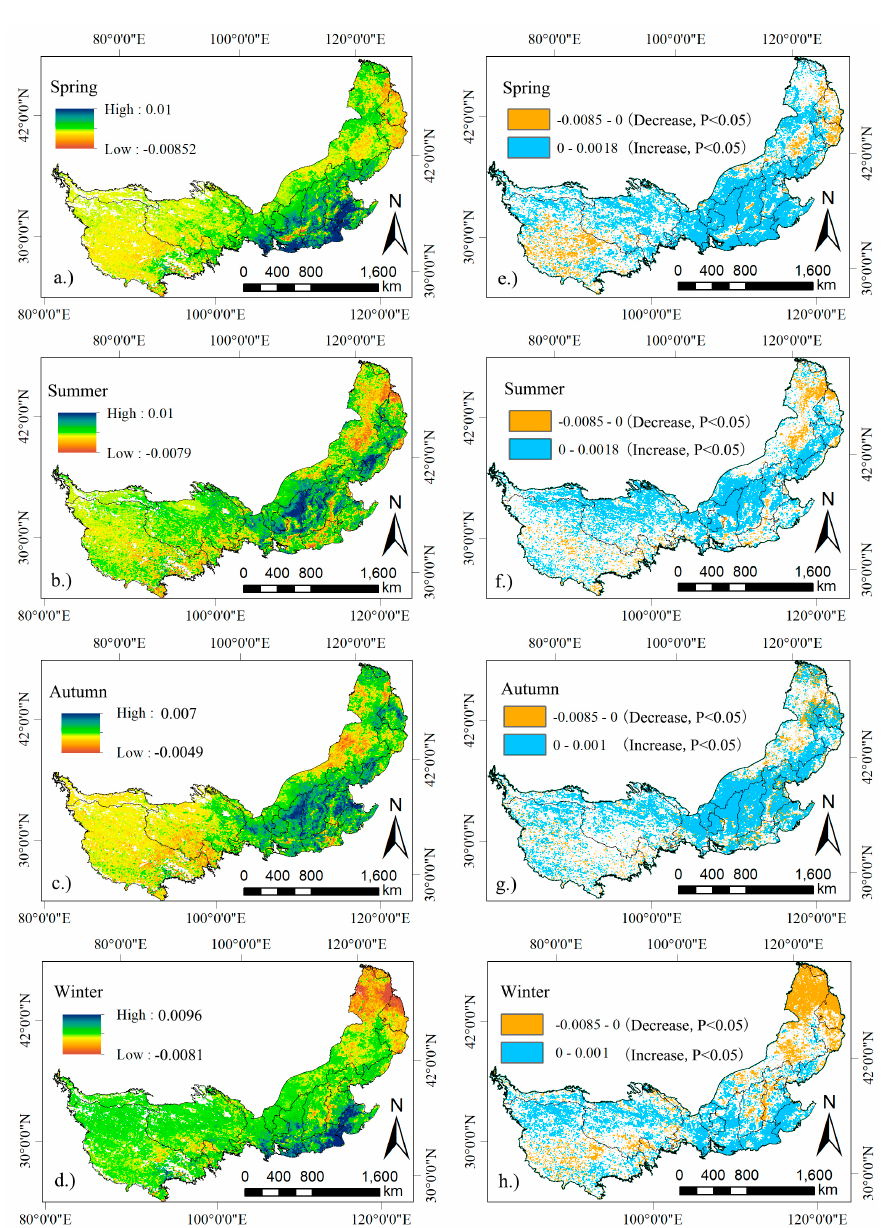
Figure 4. Vegetation NDVI variation trend and significance test of seasonal vegetation (a – h).